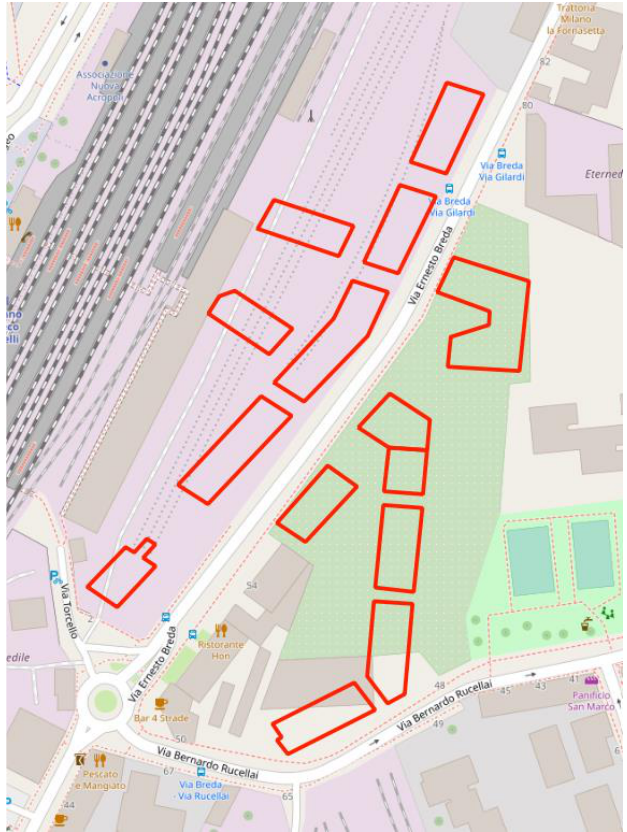
Figure 3. Representation of the positions of the buildings in the district (red shapes).